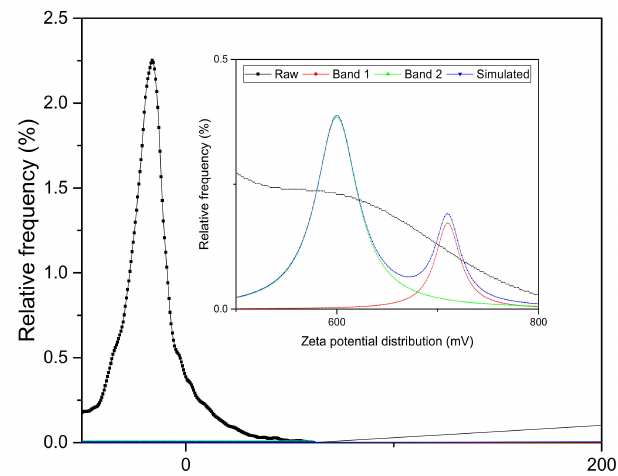
Figure 2. Zeta potential of ZrO 2 -TiO 2 nanoparticles with inset showing the deconvolution of two